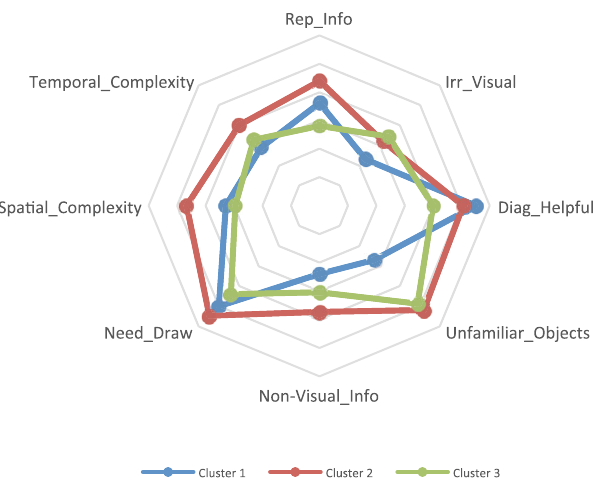
FIG. 8. Radar graph for the average rating of each problem